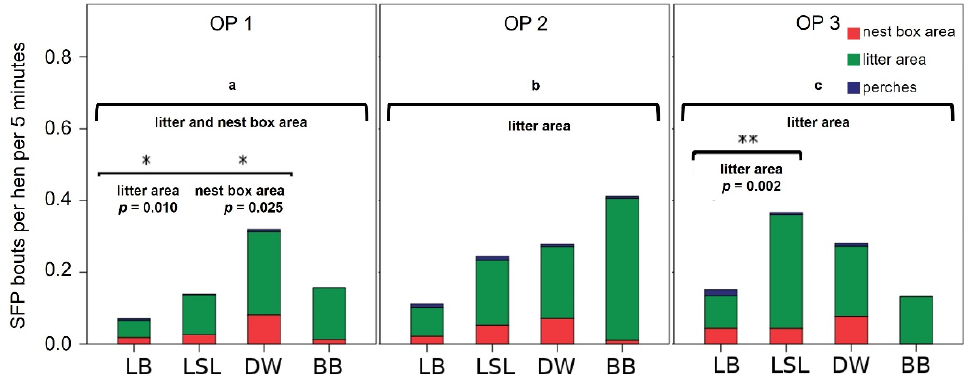
Figure 3. Mean occurrence of severe feather pecking (SFP) in non-beak-trimmed hybrid lines in dif- ferent functional areas during three observation periods (OPs). Statistical test for differences between the hybrid lines: Kruskal–Wallis test, 1- or 2-fold (general and pairwise), significant: (*) = p ≤ 0.050; (**) = p < 0.010. General: comparison of the pecking behavior between the different laying hen hybrids in the functional areas in general; a = significant differences between the laying hen hybrids in the litter area and the nest-box area in OP 1; b and c = significant differences between the laying hen hybrids in the litter area in OP 2 and OP 3. Pairwise: comparison of laying-hen hybrids in pairs in functional areas with significant differences; bracket between the laying hen hybrids = significant p -value of the pairwise tests. OP 1: 28th to 33rd week of life; OP 2: 42nd to 48th week of life; OP 3: 63rd to 68th week of life. LB = Lohmann Brown ( n = 45 cameras), LSL = Lohmann Selected Leghorn ( n = 19 cameras), DW = Dekalb White ( n = 12 cameras), BB = Bovans Brown ( n = 6